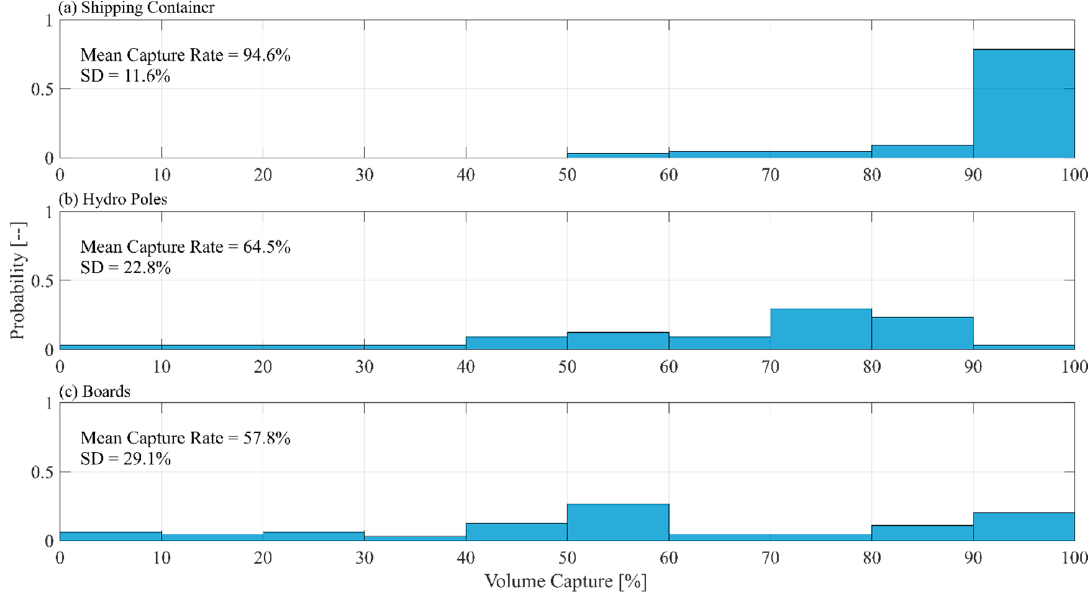
Figure 8. Capture efficiency of the debris types for all experiments: ( a ) Shipping Containers (SC); ( b ) Hydro Poles (HP); and ( c ) Boards (B).